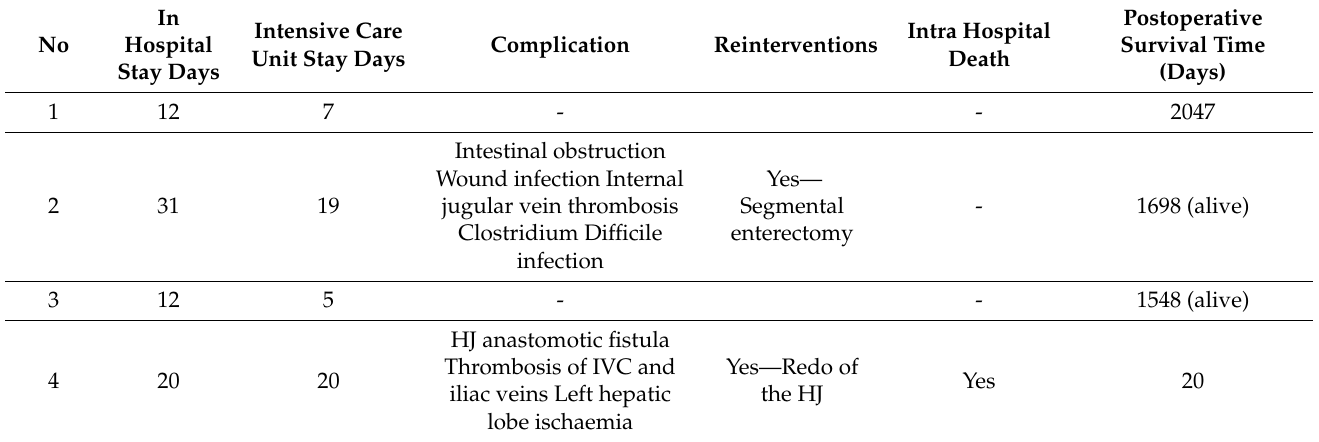
Table 3. Data on the postoperative evolution of the